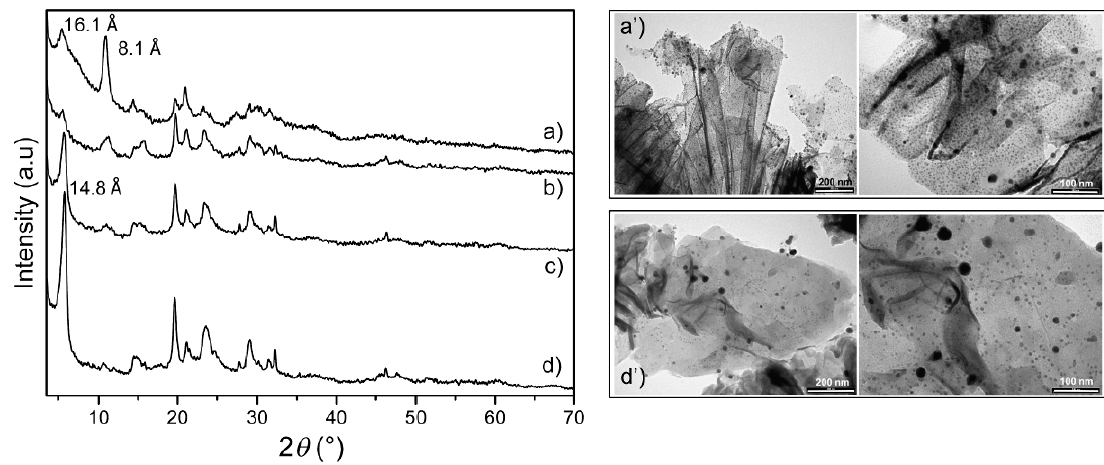
Figure 3. XRPD patterns and TEM images of Ag@ZG-1, ( a , a’ ); Ag@ZG-0.5, ( b ); Ag@ZG-0.25, ( c ); and Ag@ZG-0.125, ( d , d’ ).